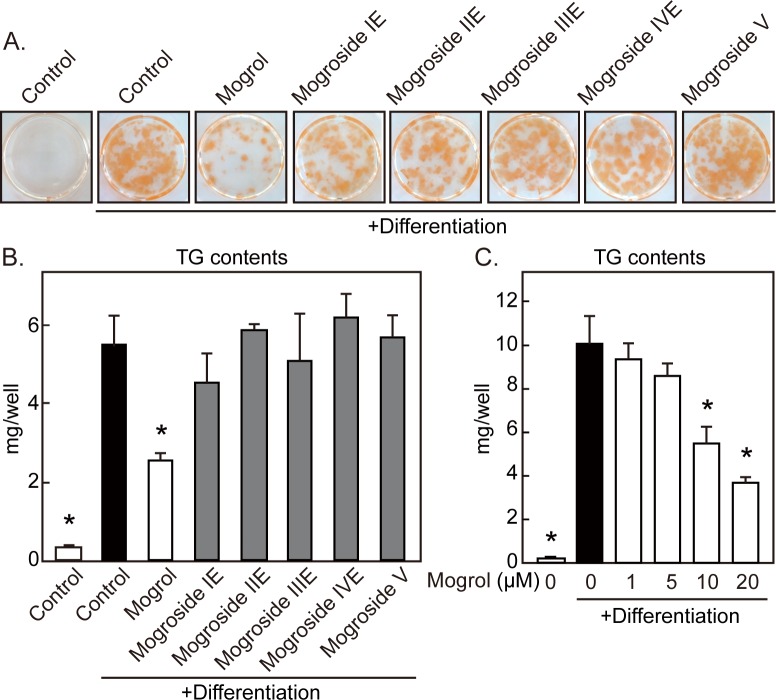
Effects of mogrol and its glycosides on lipid accumulation by 3T3-L1 cells during differentiation.3T3-L1 cells were differentiated in the presence of mogrol (20 μM) or its glycosides (20 μM) for 8 days. (A) Representative images of Oil Red O staining derived from three independent experiments. (B,C) Mean ± SD cellular TG levels derived from a representative of independent experiments. Error bars indicate the SD of three replicates. *p < 0.05 for the comparison with cells differentiated in the absence of mogrol (solid black bar), one way ANOVA and Dunnett’s post-hoc testing.